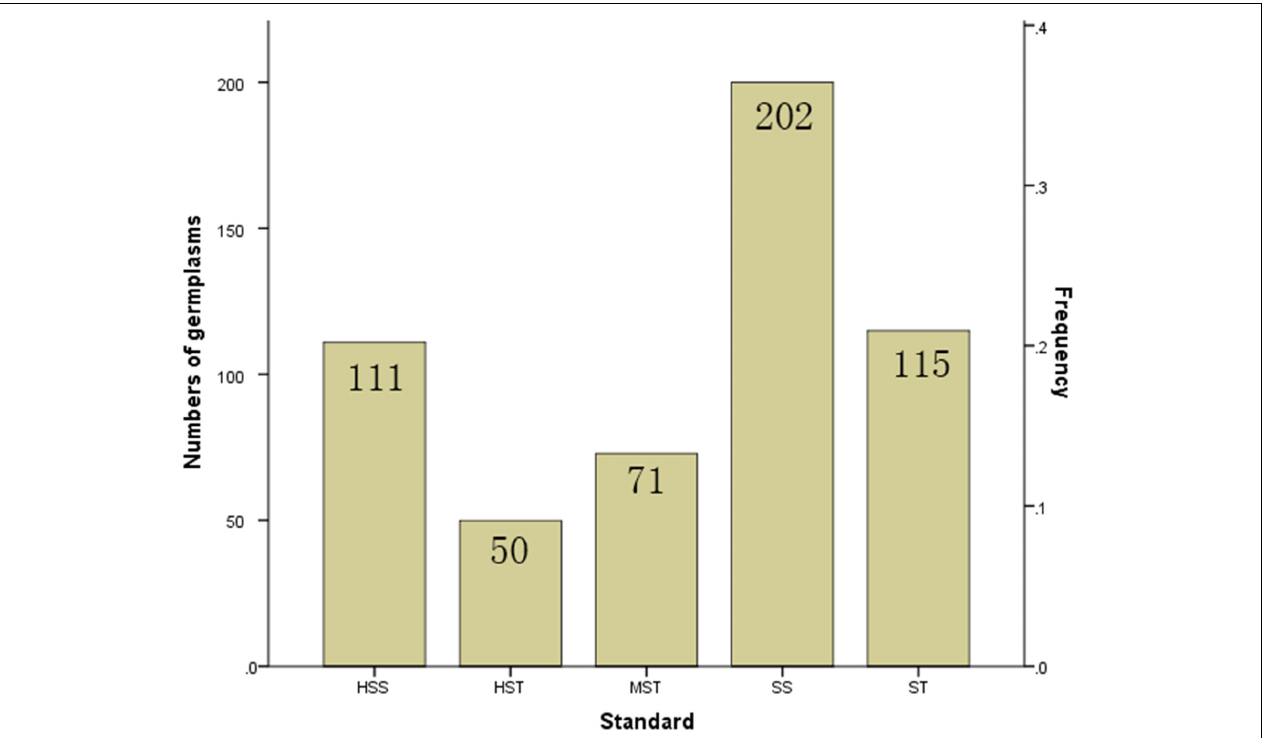
FIGURE 3 | Proportion of the 549 B. napus inbred lines with different salt tolerances. HST, highly salt tolerant; ST, salt tolerant; MST, moderately salt tolerant; SS, salt sensitive; HSS, highly salt sensitive based on hierarchical cluster analysis of salt tolerance.